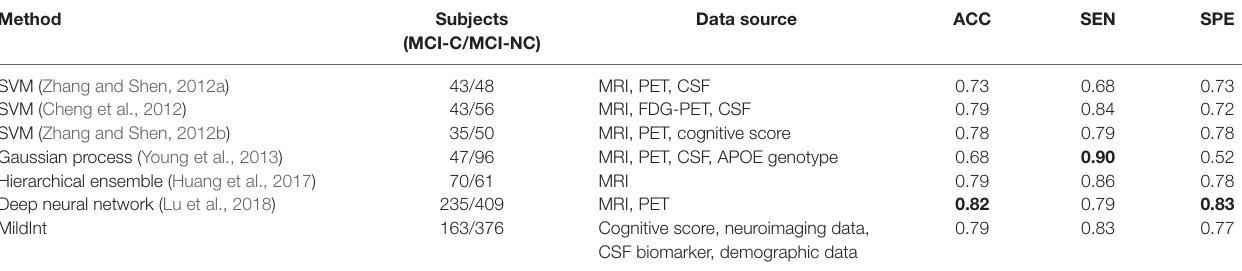
TABLE 2 | A list of previous models that train classifiers mainly with mild cognitive impairment (MCI)